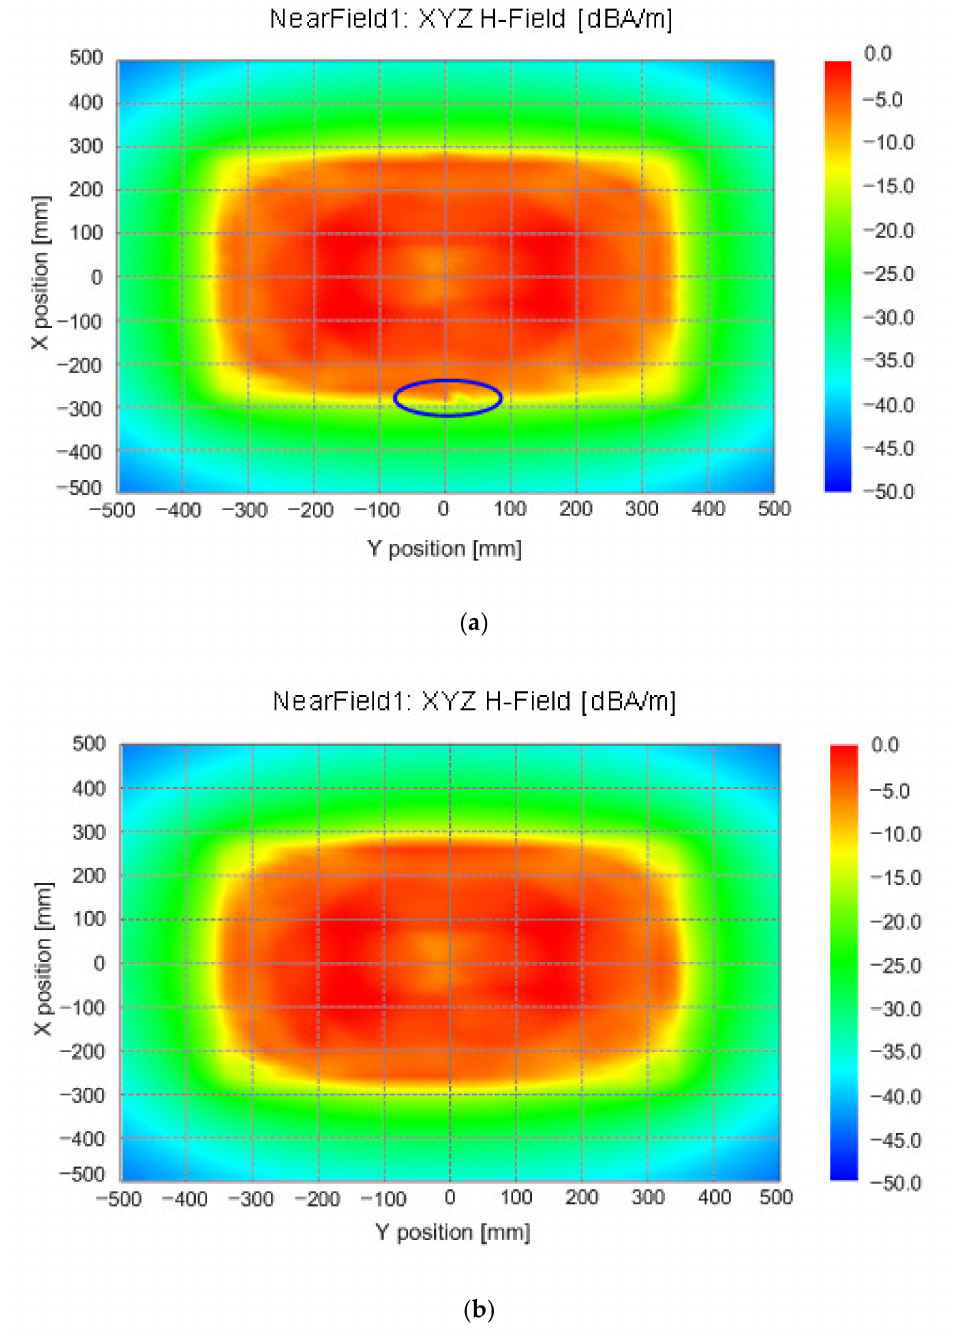
Figure 8. Simulation results when the ferrite antenna is mounted on the center of each side of the WPT system for EV. ( a ) Keyless entry system; ( b ) smart key